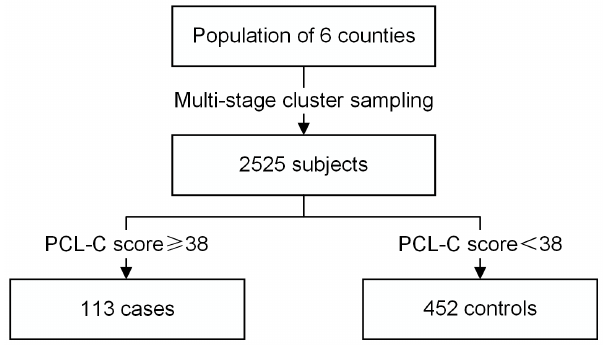
Figure 1. Flow chart of sampling.